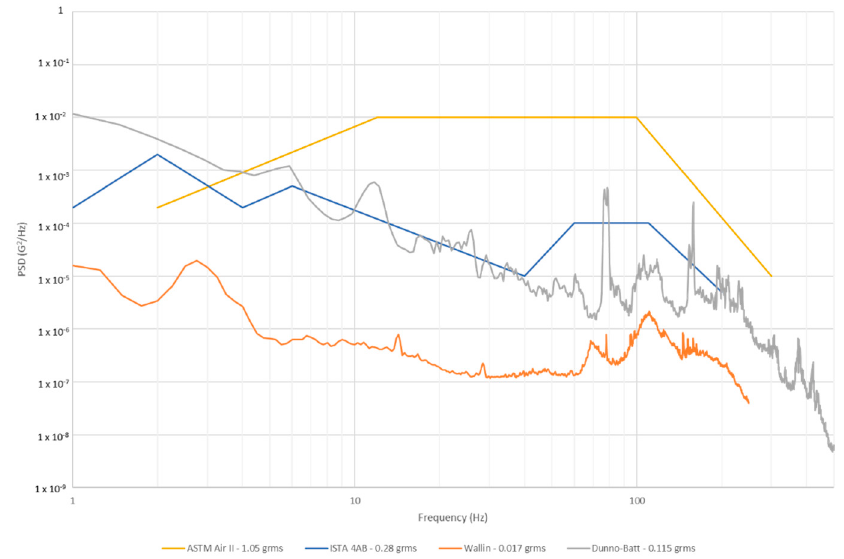
Figure 1. Air vibration PSD profile comparison.